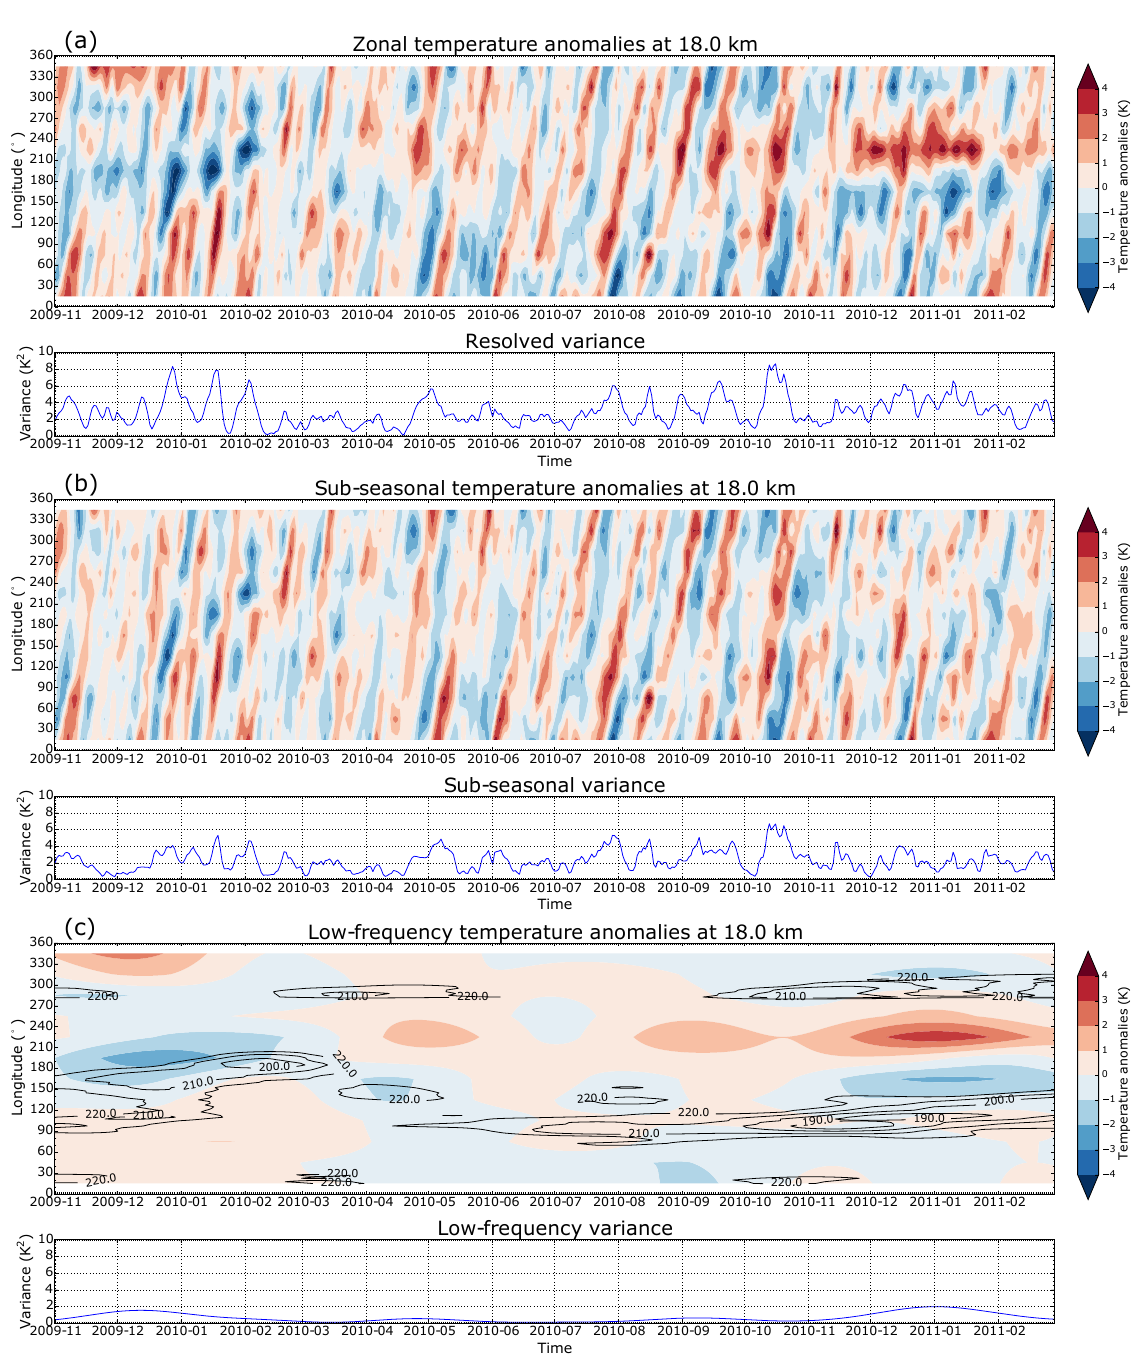
Figure 3. Hovmöller diagrams of zonal, sub-seasonal, and low-frequency temperature anomalies (top to bottom) at an altitude of 18km from November 2009 to February 2011. Temporal evolutions of associated zonal mean variances are plotted at the bottom of each panel. Contour lines in panel (c) denote strong convection (low-frequency filtered OLR (Wm − 2 ) averaged over 10 ◦ S to 10 ◦ N).